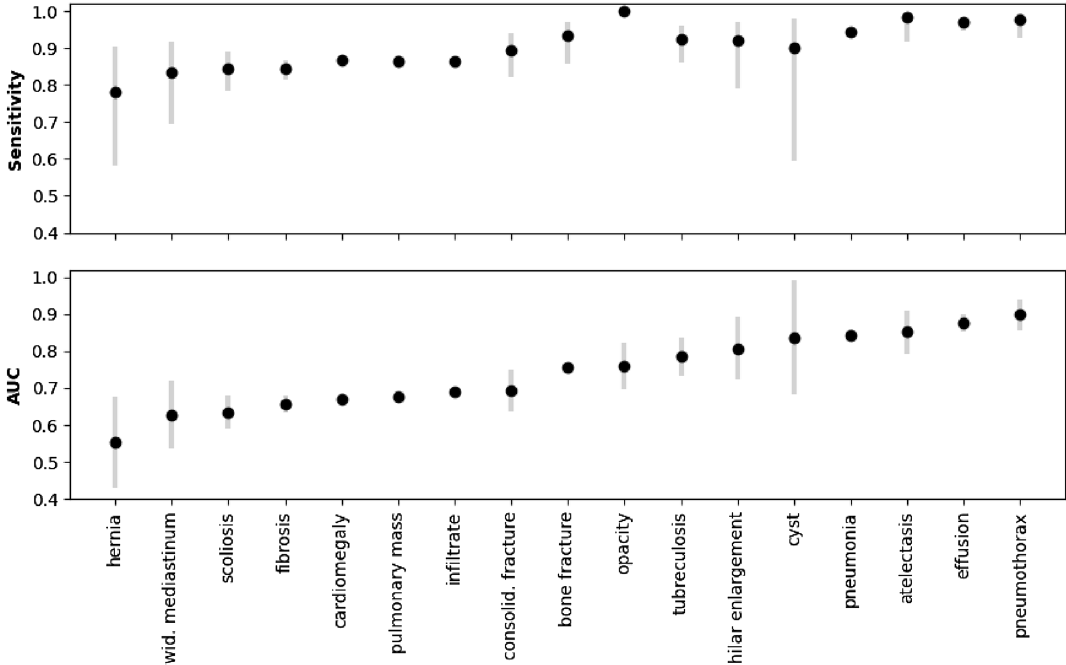
Figure 1. The results of proposed framework on the experiment database. The results are presented in terms of the sensitivity and area under the receiving operator curve (AUC) with 95% confidence intervals. The abnormalities are sorted according to the average value of the AUC. The recognition of consolidated bone fractures has not been counted towards the overall algorithm performance.